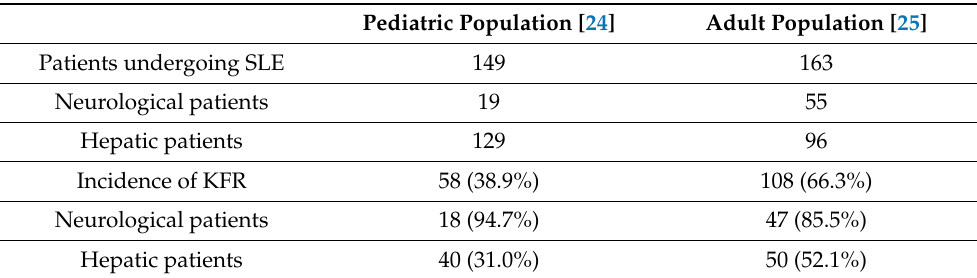
Table 1. Incidence of Kayser–Fleisher Ring (KFR) according to the form of the disease and the population. Pediatric Population [24] Adult Population [25] Patients undergoing SLE